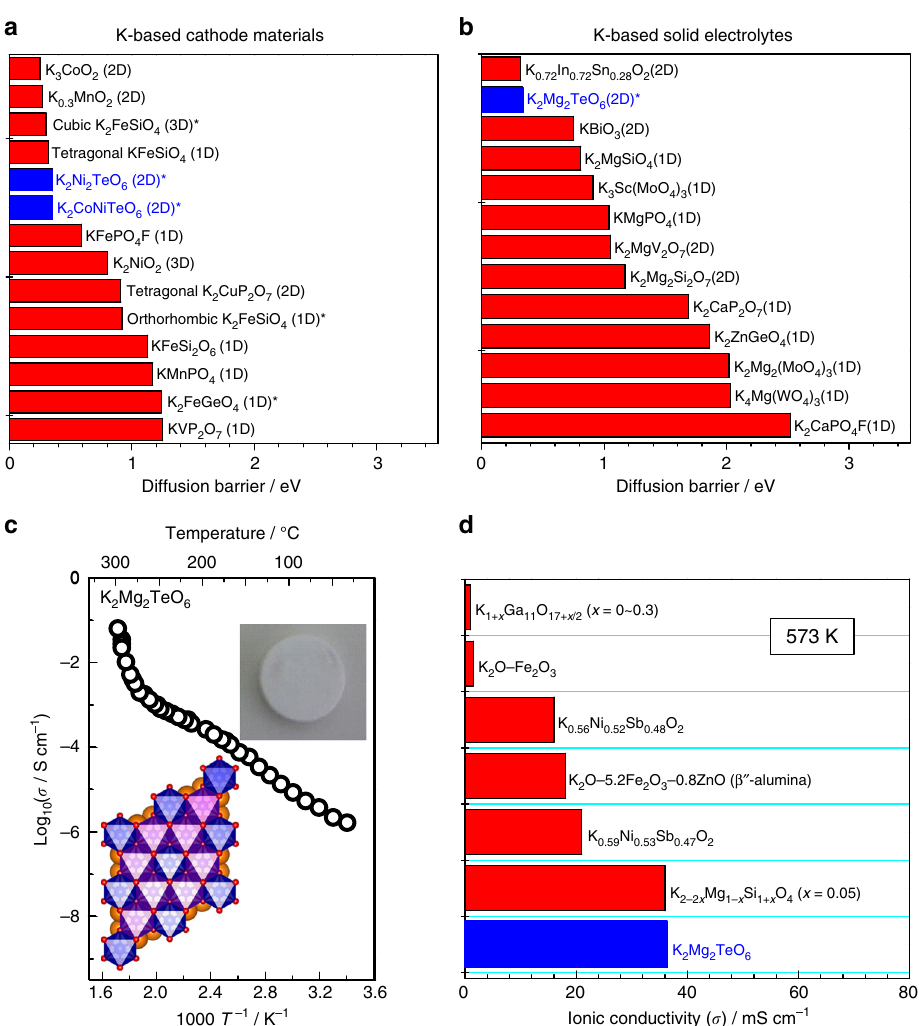
Fig. 2 Theoretical screening of tellurate frameworks (as feasible cathodes and potassium-ion conductors) and conductivity measurements of the true ionically conducting K 2 Mg 2 TeO 6 . Values of the diffusion barriers derived from BVEL isosurface maps of representative a potassium-based cathode materials and b solid electrolytes for rechargeable potassium-ion (K-ion) battery. Note that new compounds are highlighted in asterisks whereas the dimensionality of the K-ion diffusion are shown in brackets. c Alternating current (a.c.) bulk ionic conductivity plots for K 2 Mg 2 TeO 6 at temperature ranges of between 25 and 300 °C. d Bar graphs benchmarking the performance of orthotellurate compositions with the reported K-ion superionic conductors at 300 °C (573 K), references of which are provided in the Supplementary Table